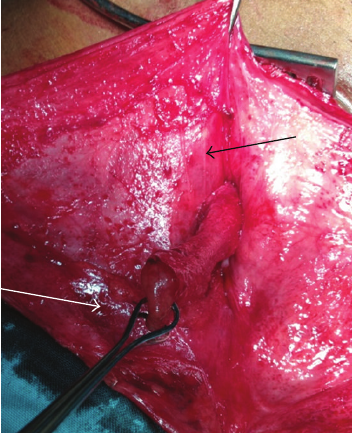
Figure 2: Superior view of appendix (white arrow) within right inguinal hernia sac (indicated by black arrow).